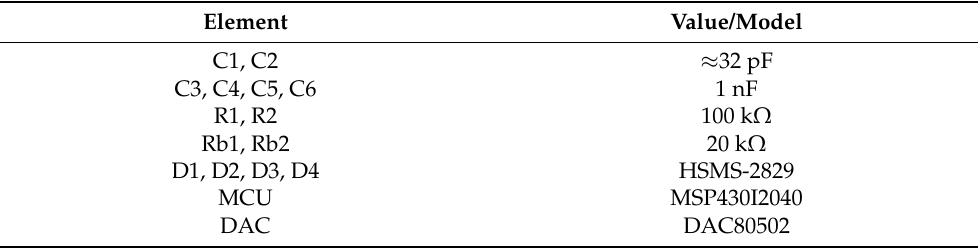
Table 1. Closed-loop control circuit element parameters.